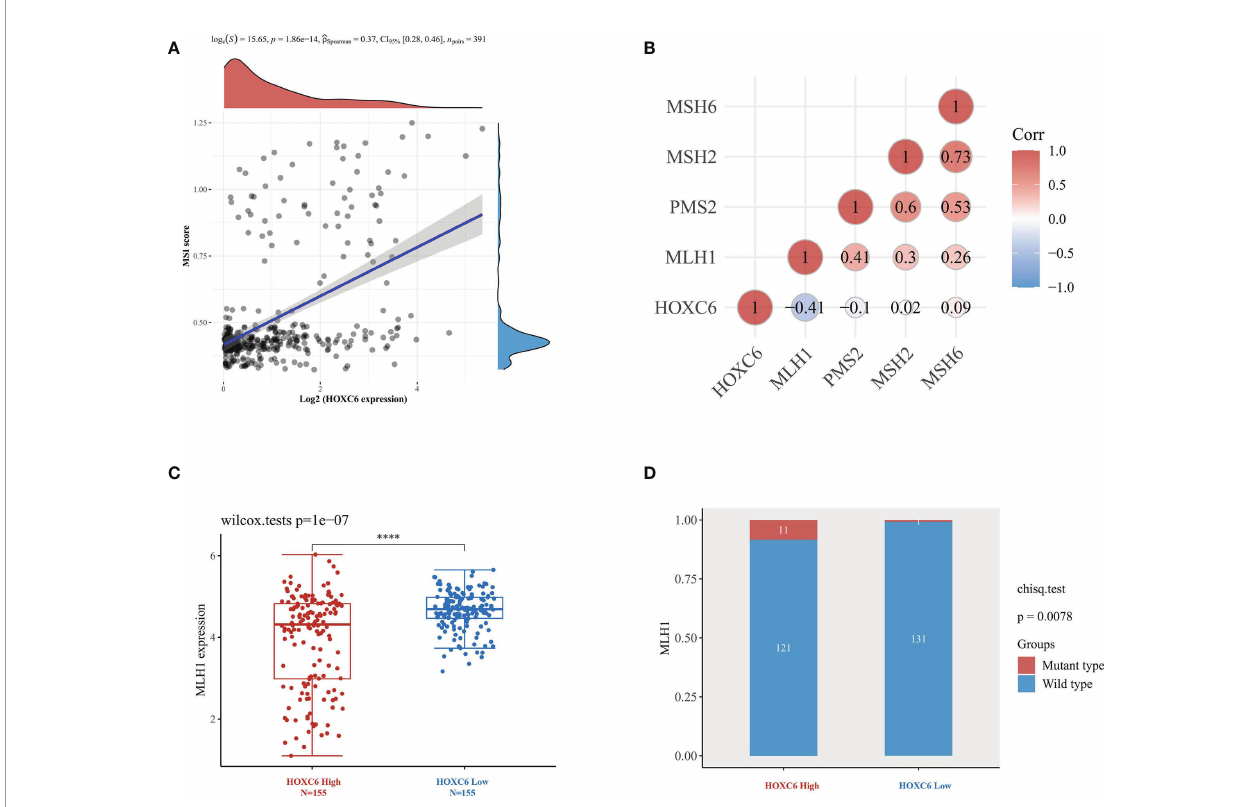
FIGURE 6 | High expression of HOXC6 was signi fi cantly correlated with high MSI-H score and dMMR status in CRC. (A) The expression of HOXC6 had a signi fi cantly positive correlation with MSI score ( P <0.001, R=0.36). (B) The expression of HOXC6 had a signi fi cantly negative correlation with the expression of MLH1 ( P <0.001, R=-0.41). (C) The expression of MLH1 was signi fi cantly downregulated in the HOXC6 high-expression group compared to the low-expression group ( P <0.001). (D) The number of patients with MLH1 mutations was signi fi cantly higher in the HOXC6 high-expression group than in the low-expression group ( P =0.0078). **** P <